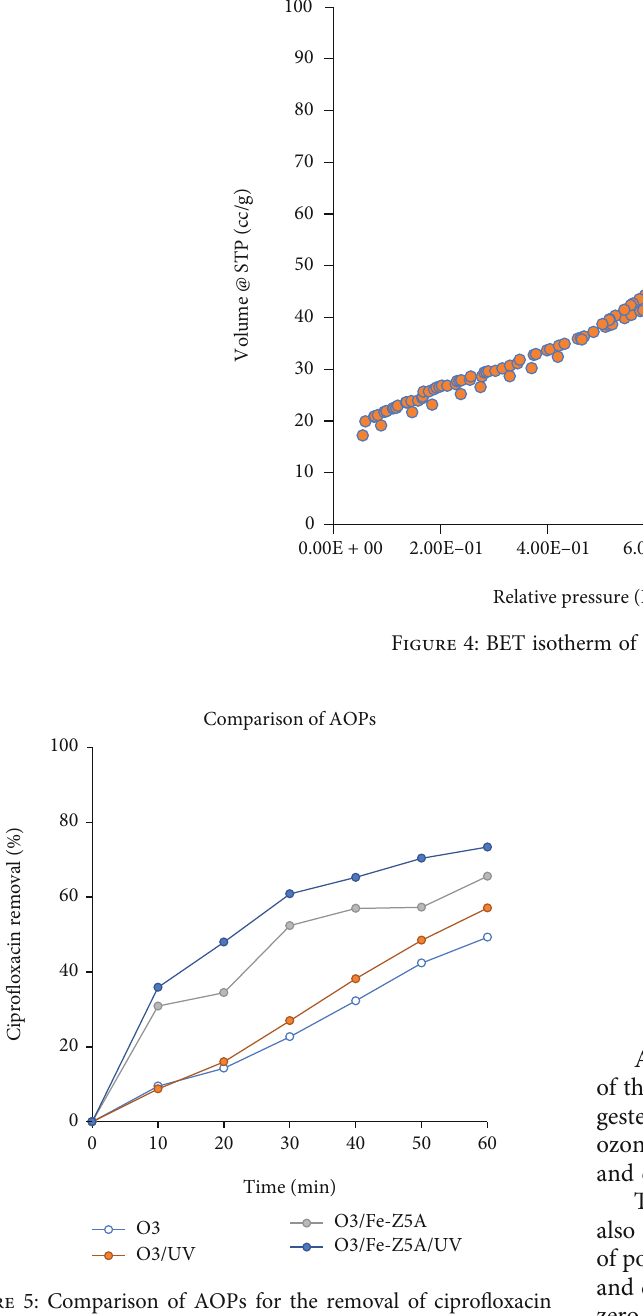
= 0 : 9 mg/L ; volume = 2 : 5 L ; 3